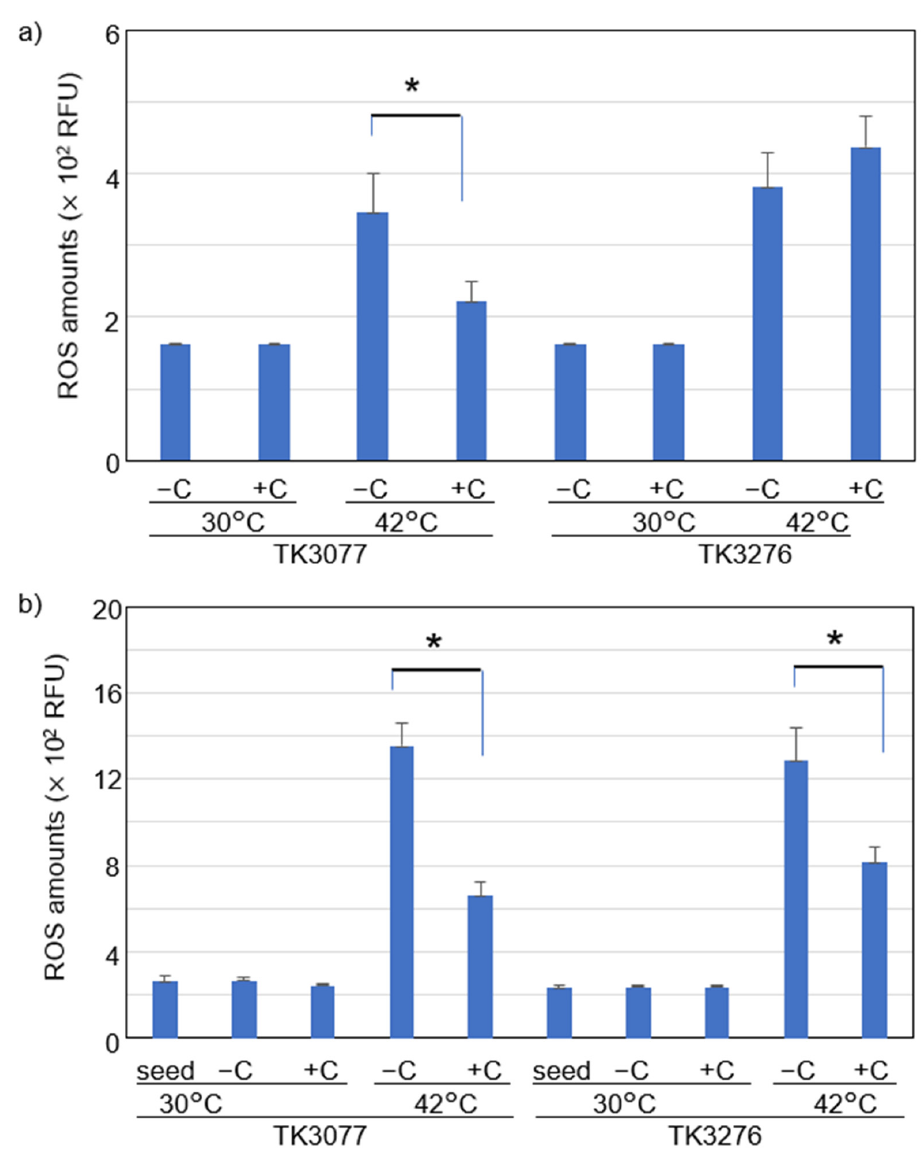
Figure 5. Vitamin C effect on mean reactive oxygen species (ROS) levels of recAts polA cells and recAts polA Δ hslO cells in permissive and restrictive conditions. ( a ) Mean ROS level suppression at a restrictive temperature in the shift-up experiments. In the early logarithmic growth phase (O.D. 600 = 0.1), the TK3077 ( recAts polA ) and TK3276 ( recAts polA Δ hslO ) cultures were divided into four portions, and each was incubated either with or without vitamin C at 30 °C and 42 °C. The mean ROS levels in the TK3077 and TK3276 cells were determined using CellROX Deep Red staining. The treatment combinations for each bar are shown from left to right: cell culture without vitamin C ( − C) or with 100 μ M vitamin C (+C) at both 30 °C and 42 °C for TK3077 and TK3276 cells. Each bar represents the average and standard error of the mean (SEM) (n ≥ 7). * p < 0.05, according to Welch’s t- test (n = 7). ( b ) Mean ROS level suppression at a restrictive temperature in inoculation experiments. TK3077 ( recAts polA ) and TK3276 ( recAts polA Δ hslO ) cells were inoculated with 1/100 of the overnight seed culture and incubated either with or without 100 μ M vitamin C at 30 °C or 42 °C for 16 h. The cell ROS levels were determined, and the ROS levels of the seed and cultured cells at 30 °C or 42 °C for 16 h were compared. Treatment combinations for each bar are shown from left to right: seed culture, cell culture without vitamin C ( − C), or cell culture with 100 μ M vitamin C (+C) at both 30 °C and 42 °C for TK3077 and TK3276 cells. Each bar represents the average and standard error of the mean (SEM) (n ≥ 7). * p < 0.05, according to Welch’s t- test (n = 7).